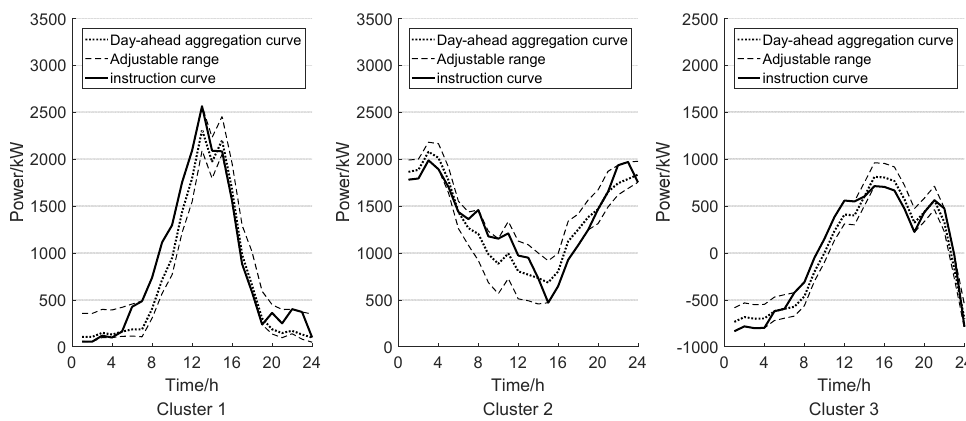
Figure 7. External power interaction curve of the system.